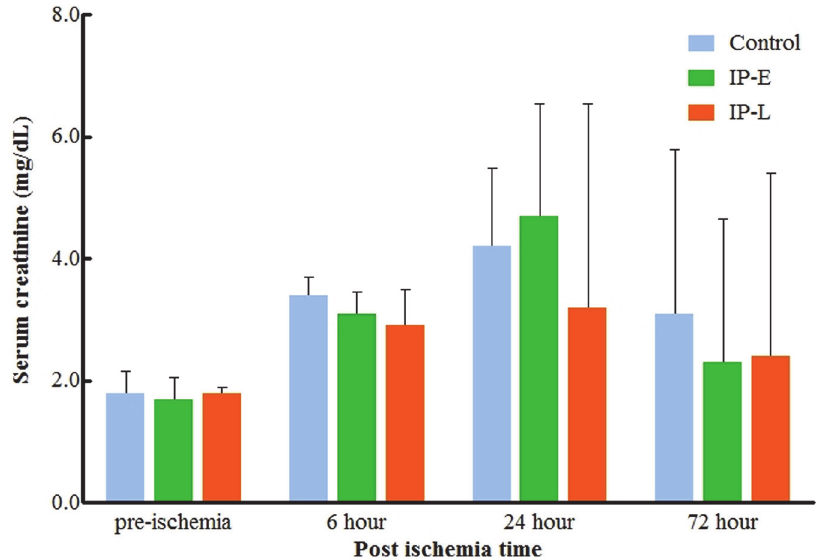
Fig 2. Changes in serum creatinine. There were no differences between groups throughout the whole experiment. SCr, serum creatinine; IP-E, remote Ischemic preconditioning with early window; IP-L, remote ischemic preconditioning with late